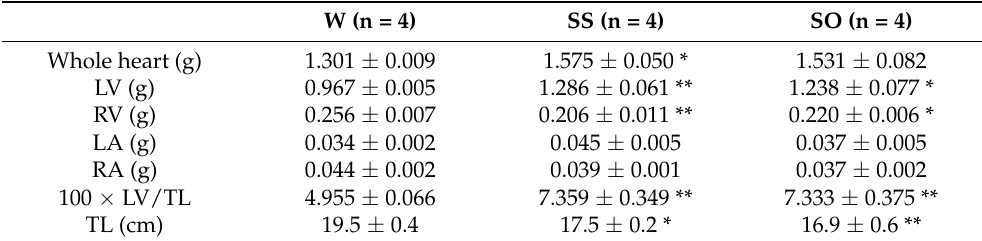
tole (A) inflow across mitral valves (E/A) indicating LV diastolic dysfunction tended to increase in SS compared with W (Figure 3C, n = 2). Human omentin-1 tended to reverse E/A in SHR (Figure 3C, n = 4). We also found a very short deceleration time (n = 4) or the absence of the A wave (n = 2) in SS for which E/A could not be calculated. Human omen- tin-1 tended to reverse the diastole time in SHR (n = 4).